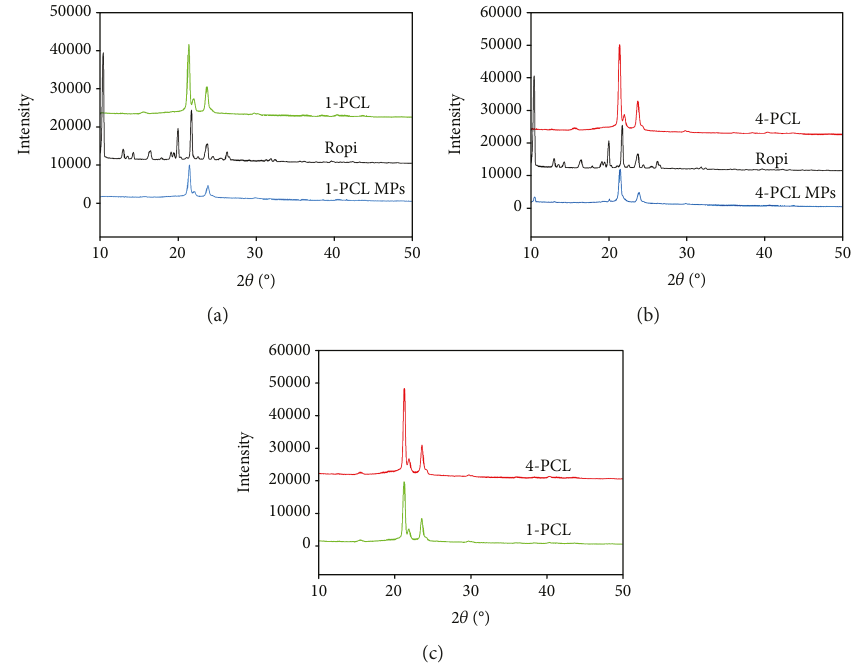
Figure 4: XRD spectra of the blank 1-PCL and the Ropi-loaded 1-PCL microsphere (a) and the blank 4-PCL and the Ropi-loaded 4-PCL microsphere (b) and comparison between the blank 1-PCL and the blank 4-PCL